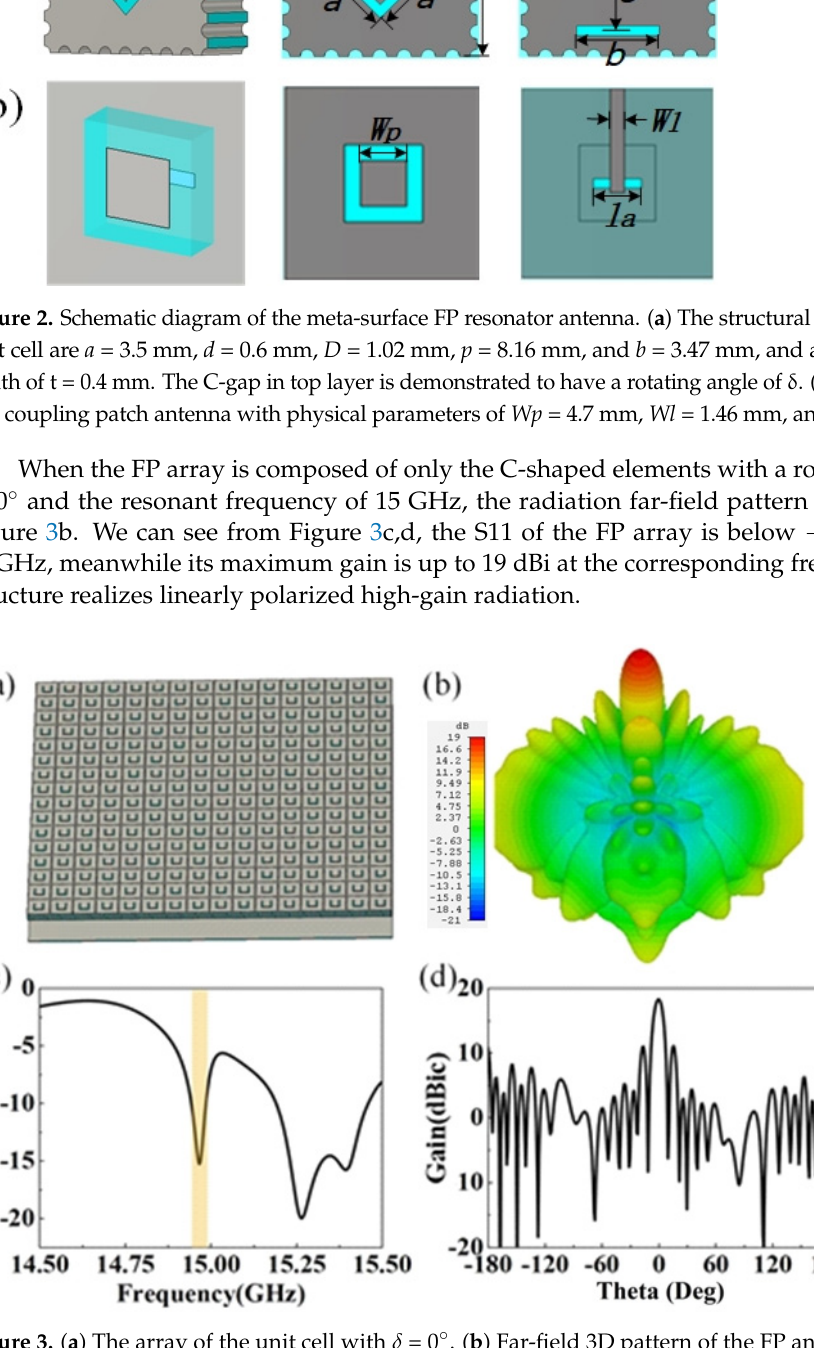
Figure 3. ( a ) The array of the unit cell with δ = 0°. ( b ) Far-field 3D pattern of the FP antenna. ( c ) S11 of the FP antenna. ( d ) Far-field 2D patterns of the beam.